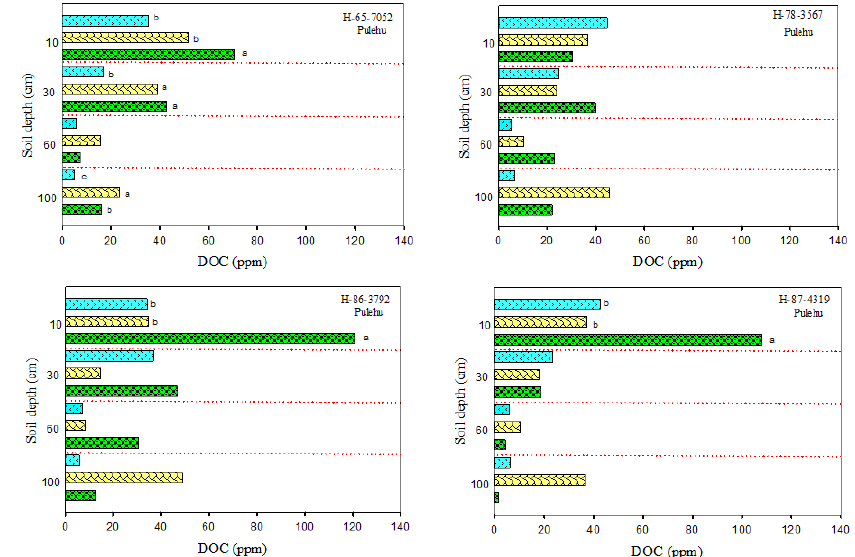
Figure 3. Dissolved organic carbon (DOC) in Pulehu soils. Color represents sugarcane growing stages ( i.e. , blue-tillering, yellow-grand growth, green-maturity) when the soil samples were collected. Means followed by the same letter or no letters for the bars in each soil depth are not significantly different Tukey’s test at Pr <